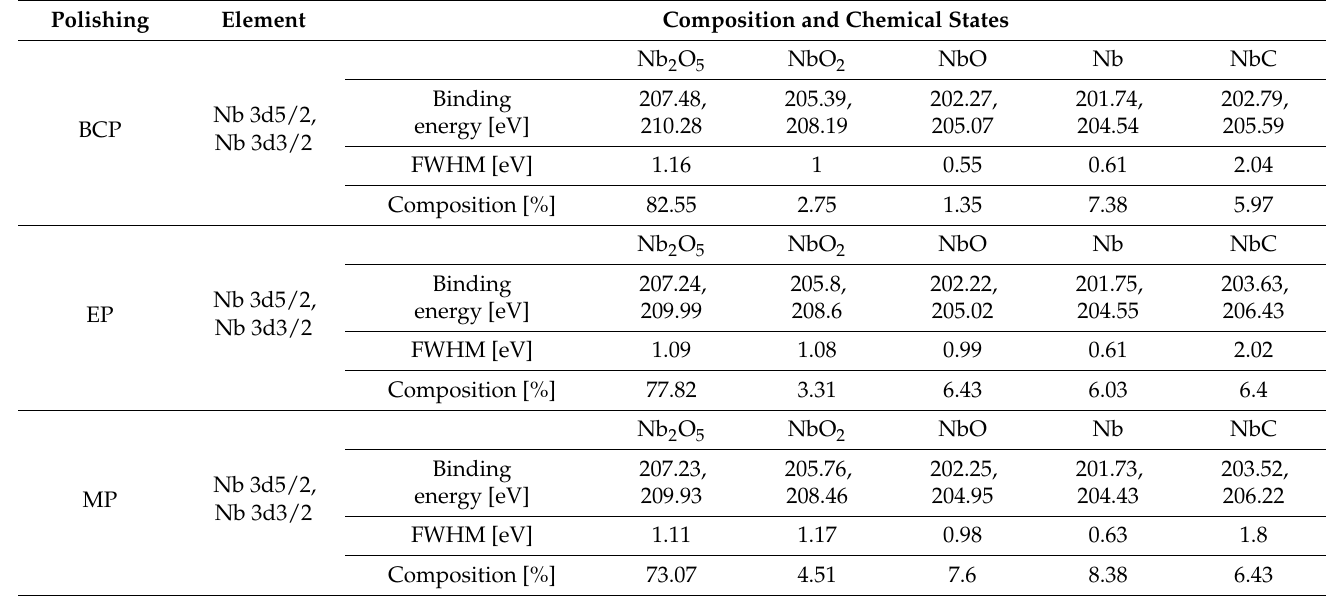
Table 2. Composition and chemical states after different polishing treatments (BCP, EP, and MP). Polishing Element Composition and Chemical